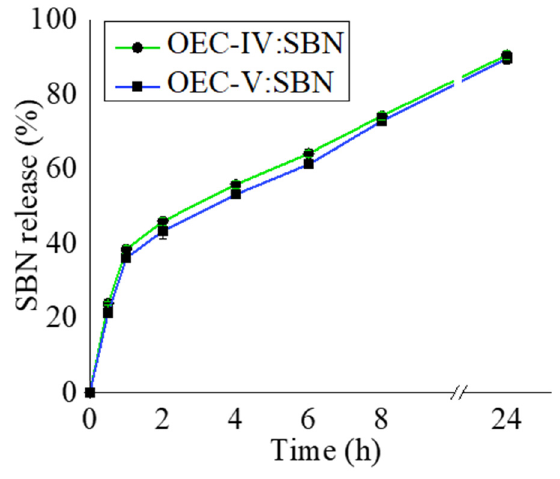
Figure 8. Release profiles of silibinin from supramolecular PEGylated tert -octylcalix[8]arenes aggregates.